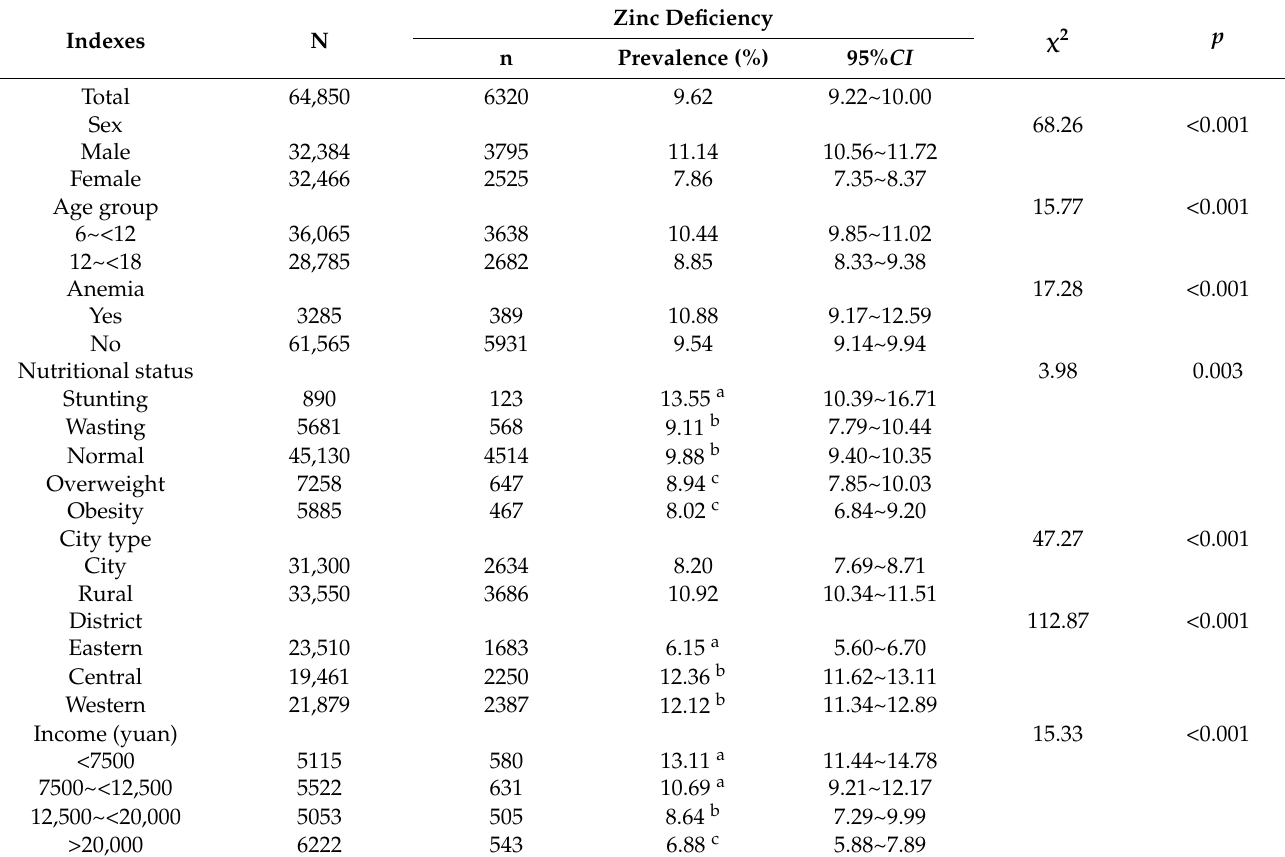
Table 2. The prevalence of zinc deficiency in Chinese 6–18-year-old